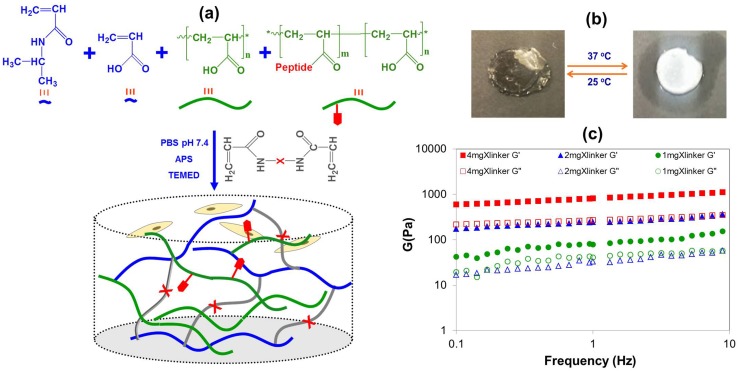
Synthesis and characterization of sIPN hydrogels.(a) Schematic for sIPN synthesis: a solution of NIPAAm, AAc, and QPQGLAK diacrylate in PBS containing p(AAc)-g-RGD undergoes free radical polymerization to form a sIPN of p(NIPAAm-co-AAc) crosslinked with an MMP-13 degradable peptide crosslinker, and interpenetrated with p(AAc)-g-RGD. (b) Evidence of phase transition behavior by sIPNs. (c) Rheological properties of the sIPNs were determined using various crosslinking densities at 37°C. The filled symbol represents the storage modulus (G′), and the open symbol represents the loss modulus (G"). Three repeated measurements were performed on each sample.